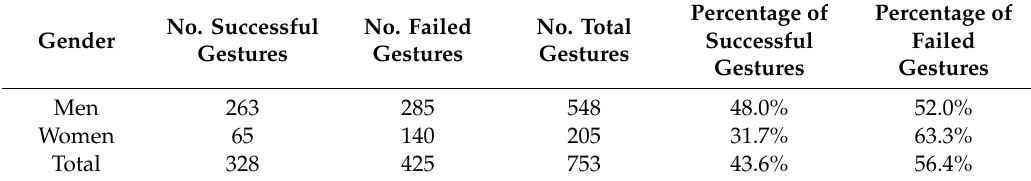
Table 5. Contingency table.